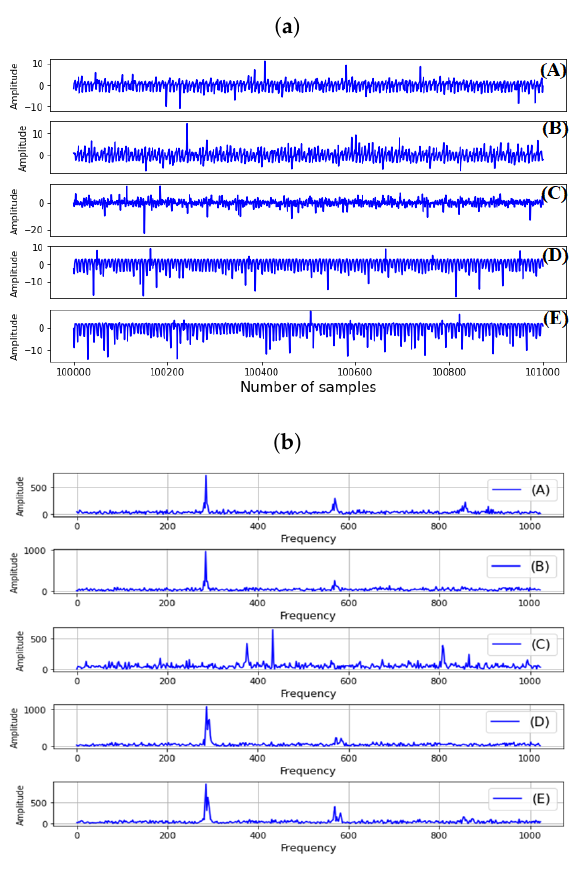
Figure 4. A view of the acquired signals from the pumps: ( a ) a view of vibration samples of the pumps and ( b ) power spectra of the pumps’ vibration